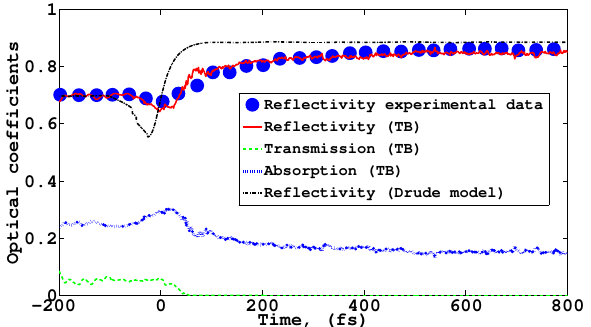
Figure 8. Optical coefficients of silicon irradiated with the absorbed dose of 1.0 eV/atom. The dots are experimental data for reflectivity [31]; the dot-dashed line represents Drude model results; the solid line is reflectivity from the TB model; the dashed line is transmission from the TB model; the dotted line is absorption from the TB model. The simulations were performed with 216 atoms in the supercell. The figure is reproduced from